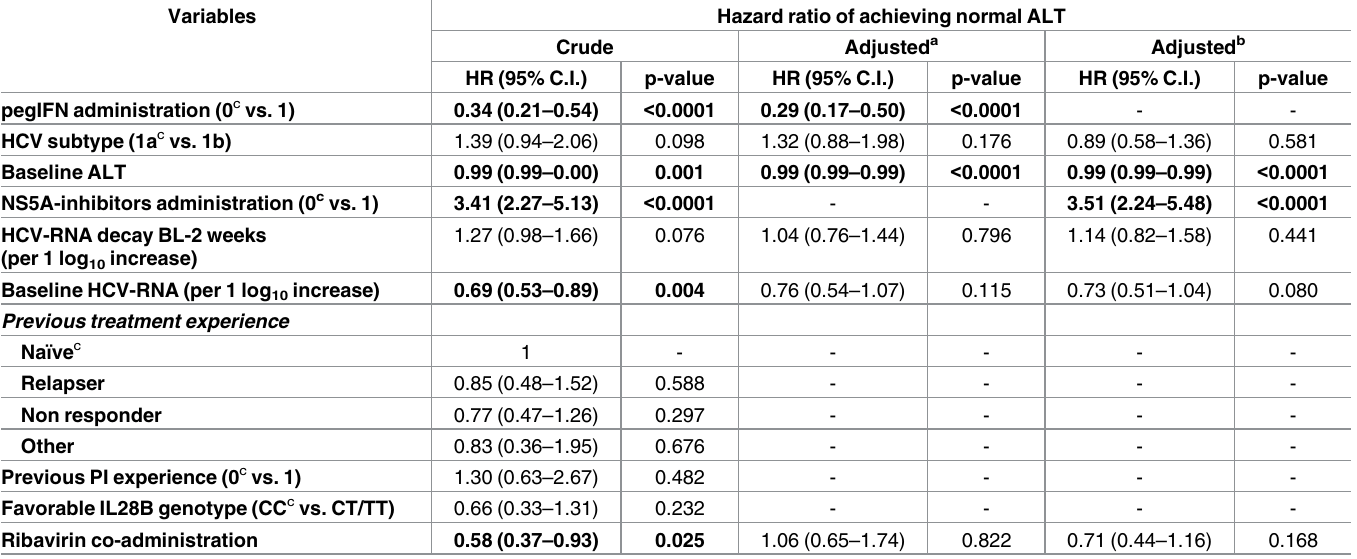
Table 3. Cox analysis for factors influencing ALT normalization during